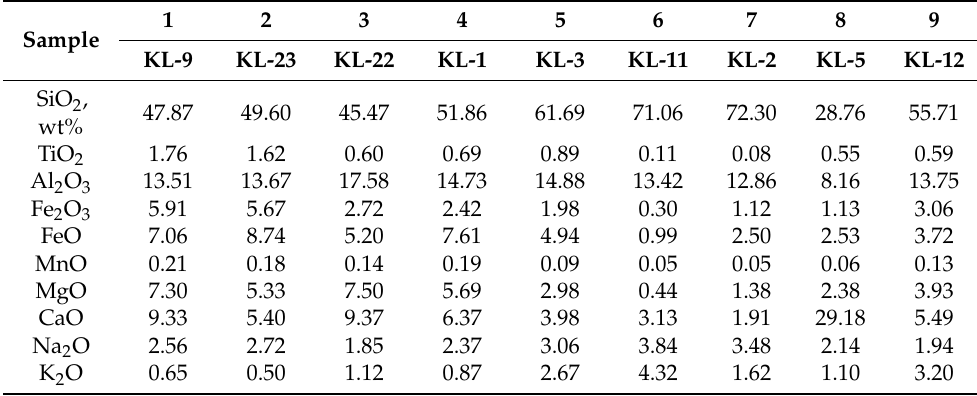
Table 1. Analytical results on representative samples of pseudotachylytes and mylonites from the MSF. MSF—Main Sayan